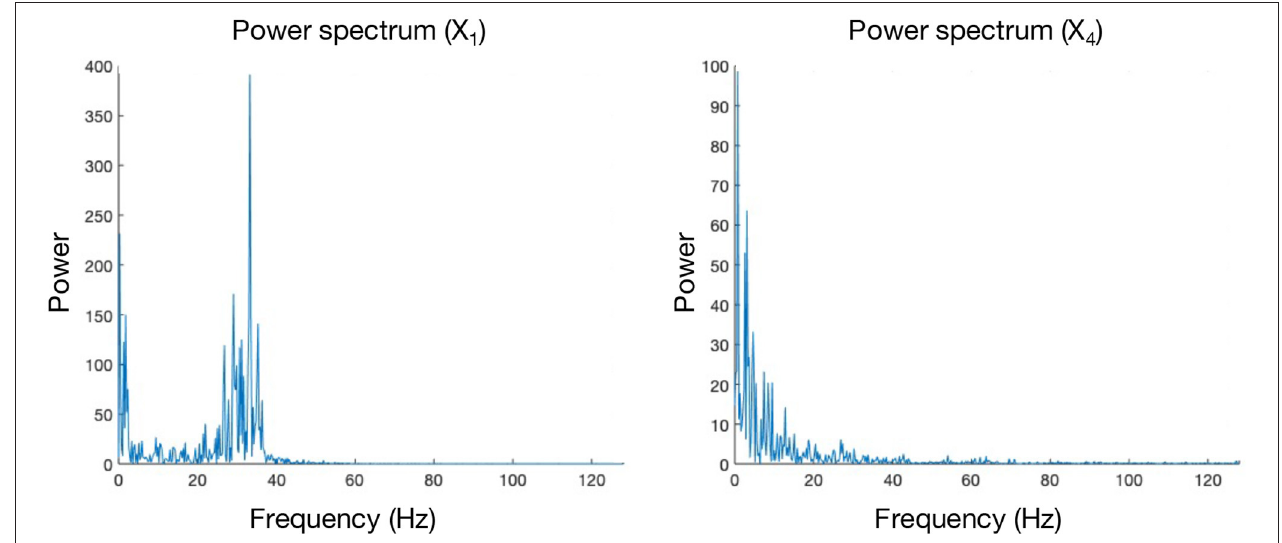
FIGURE 10 | Power spectra of signals X 1 and X 4 , obtained from a realisation of the “FreqARlin” simulation